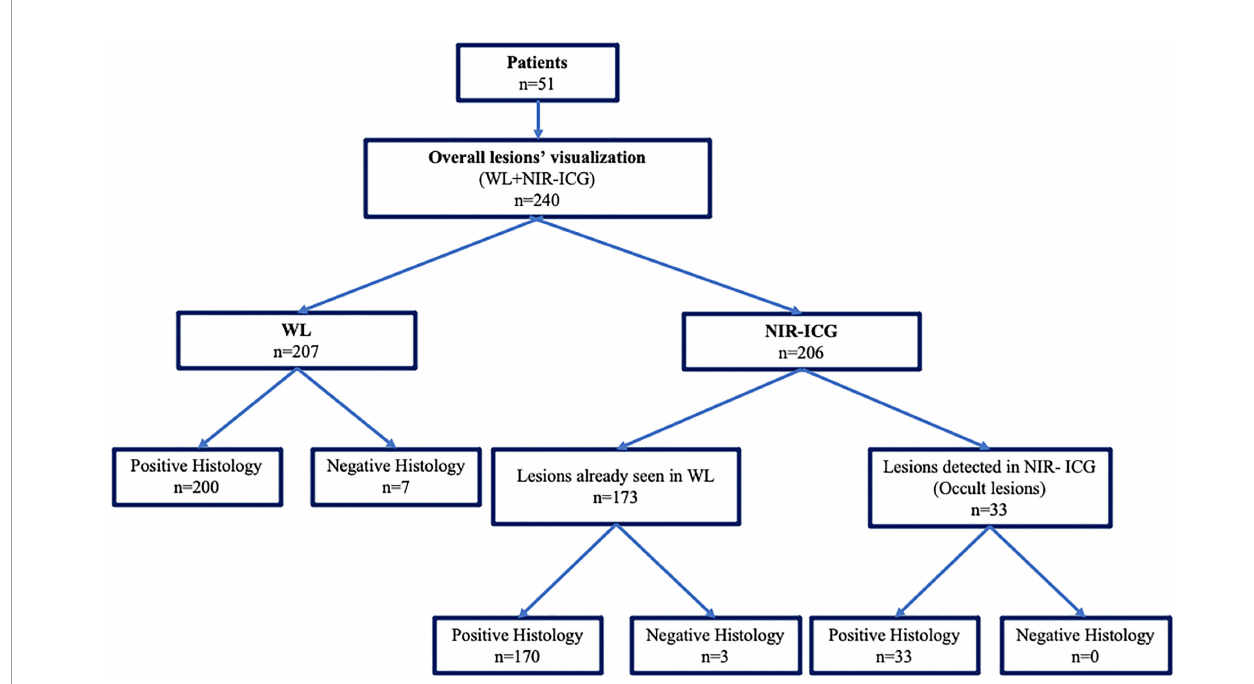
FIGURE 3 | Graphical representation of the collection of intraoperative and pathological data derived from WL vision and the combination of the two techniques (WL plus NIR-ICG).